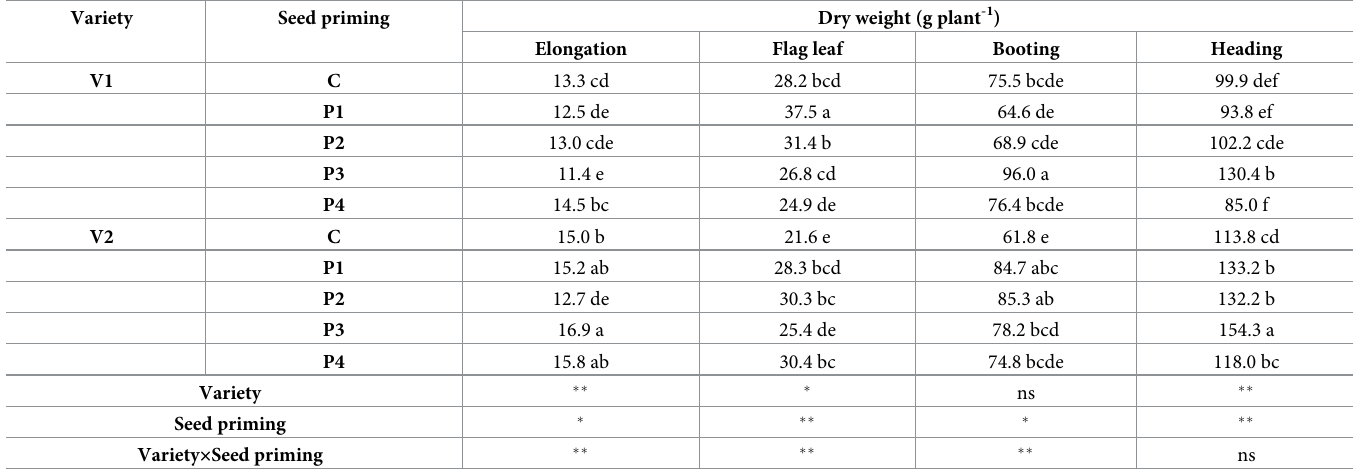
Table 2. Effects of seed priming on dry weight of sorghum under salt stress at different growth stages. Variety